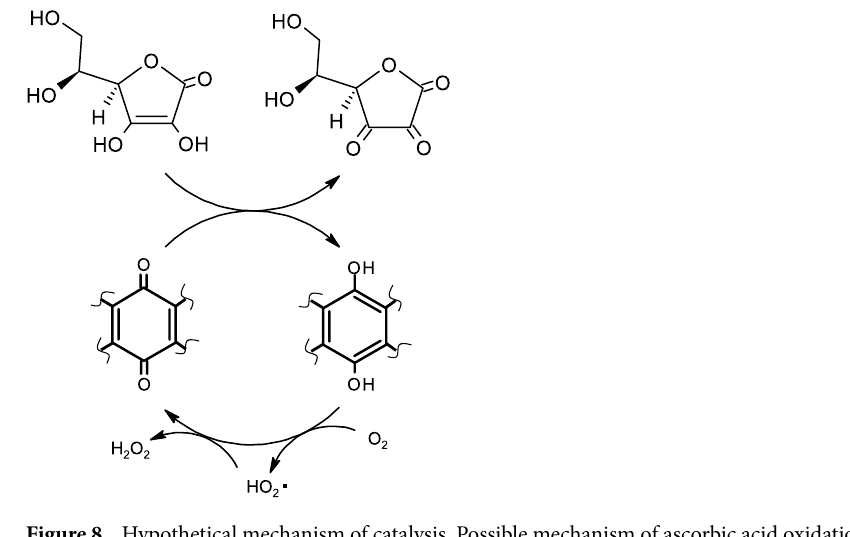
Figure 8. Hypothetical mechanism of catalysis. Possible mechanism of ascorbic acid oxidation catalyzed by granaticin and other quinolic substances. The catalytic reaction occurs because of the autonomous regeneration of the quinone form, via electron transfer from the quinol form to molecular